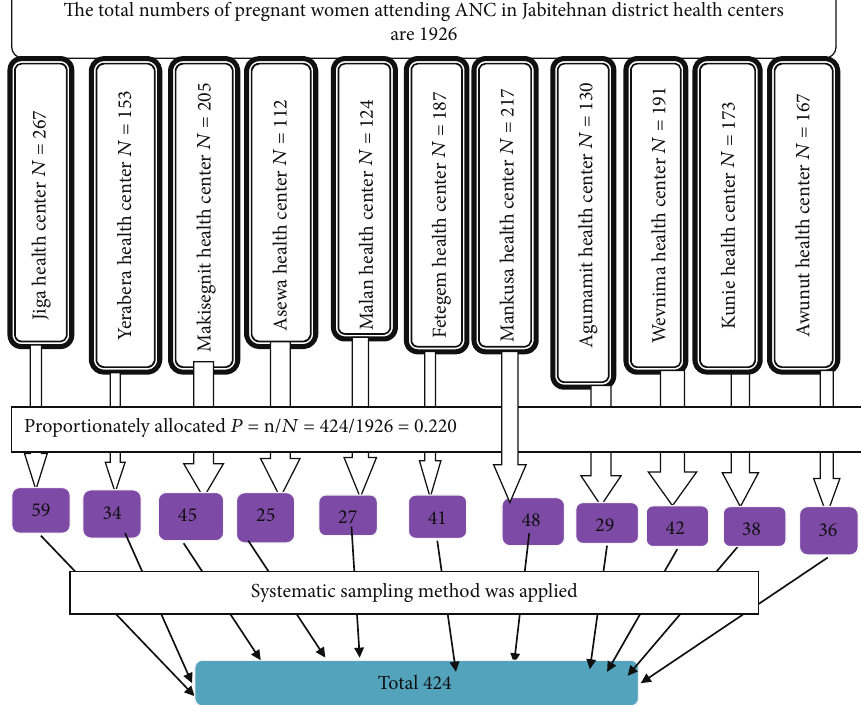
Figure 1: Sampling procedure to determine pregnancy risk perception and associated factors among pregnant women attending antenatal care at health centers in Jabi Tehnan District, Amhara, Northwest Ethiopia,